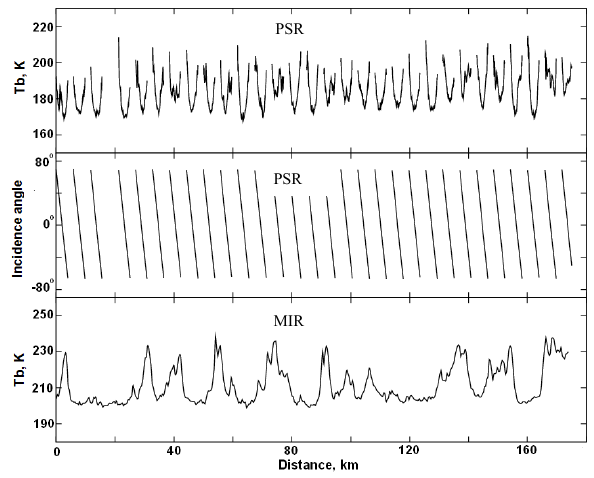
Figure 4: Examples of radiometric data obtained from the PSR and MIR deployed on the NASA P-3 research aircraft during the Wakasa Bay AMSR-E validation campaign. (a) The PSR brightness temperature as a function of distance; (b) the corresponding viewing angle; (c) the MIR nadir-viewing brightness temperature. The PSR scanned within ± 70 ° off the nadir along the flight line, providing multi-angular observations of microwave emission in the vertical plane of the flight track. The MIR was programmed to scan within a 106 ° swath across the flight track and only the nadir-viewing observations are used in this study.